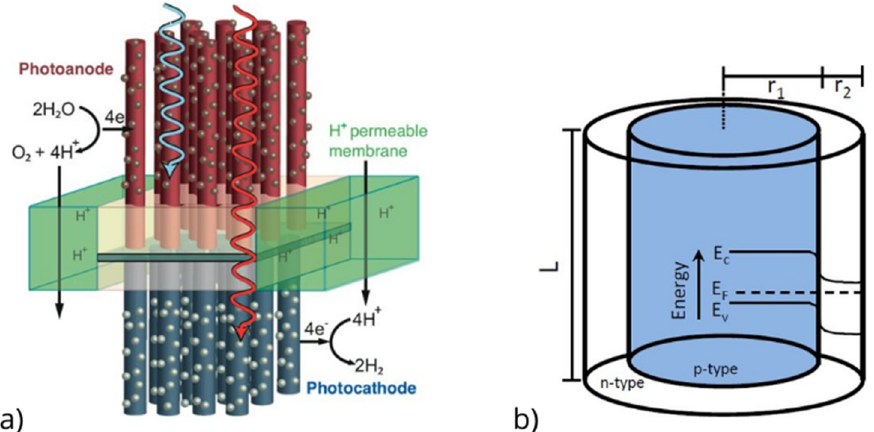
Figure 2. ( a ) Schematic of a water splitting device with two electrodes using structured solar absorbers and separated by a proton-permeable membrane for ion transport. ( b ) Schematic of a radial p–n junction, with an inner p-type core and an outer p-type shell. Inset shows the radial band-bending diagram for a p–n junction Reprinted (adapted) with permission from (E.L. Warren, H.A. Atwater